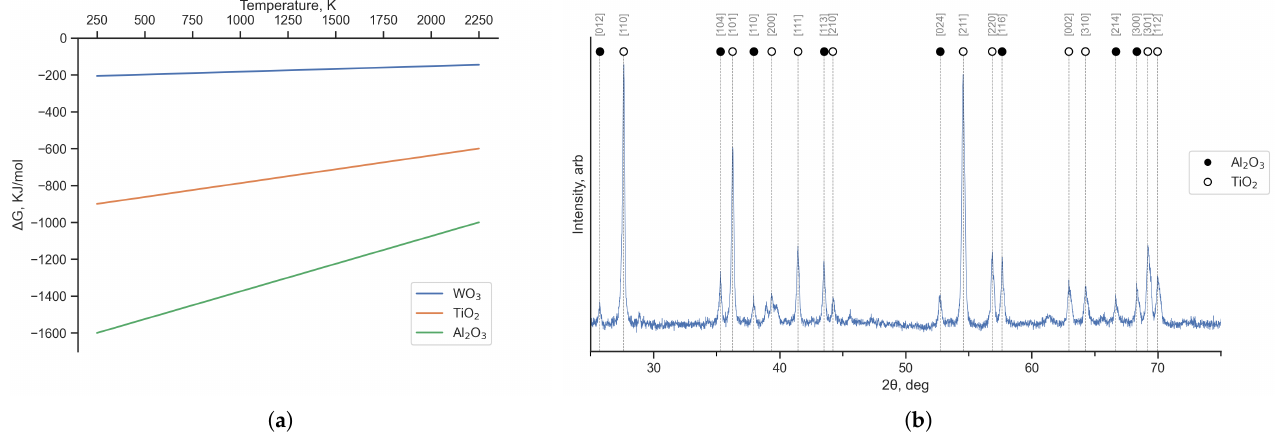
Figure 6. Gibbs free energy change ( ∆ G) for TiO 2 [68], Al 2 O 3 [68], and WO 3 [69] as function of temperature (K) ( a ) and XRD spectrum of the TAW2 sample surface after 660 min of oxidation at 900 ◦ C ( b